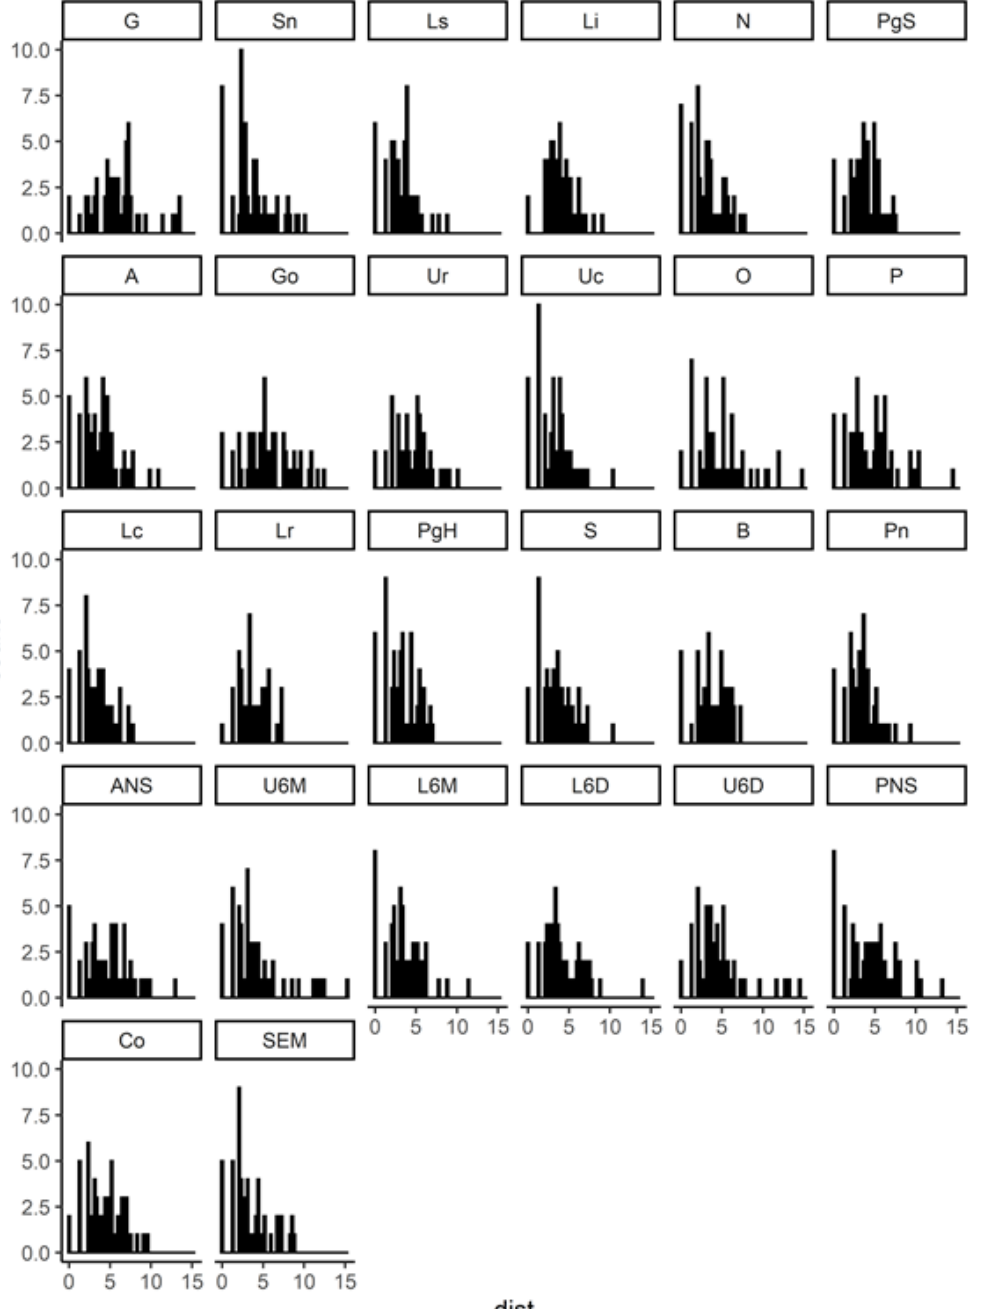
Figure 6. Prediction accuracy for each landmark. Each panel shows the distribution of the magnitude of prediction error in pixels ( x -axis) for each of the 26 landmarks.